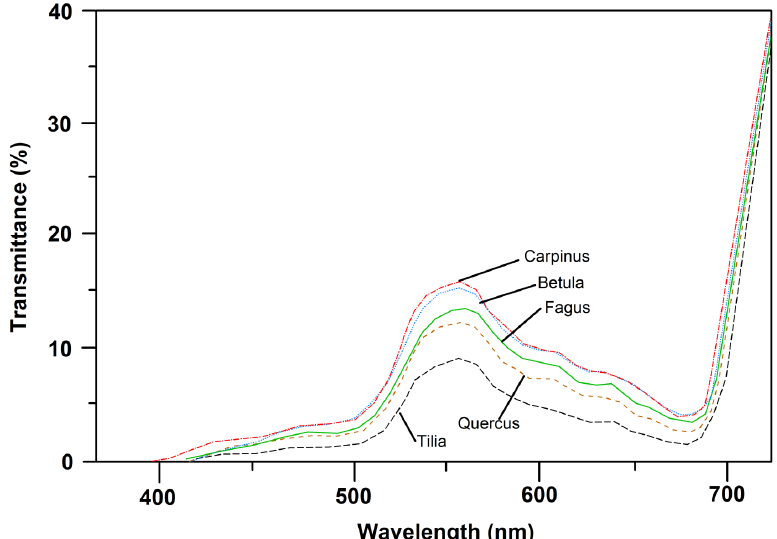
Figure 1. PAR-transmittance spectra of upper sun-canopy leaves of the five species with consideration of leaf specular properties. Depicted are mean curves of spectroradiometer measurements on each of 10 leaves per species. For standard deviation of means see Figure S3 in the Supplement.